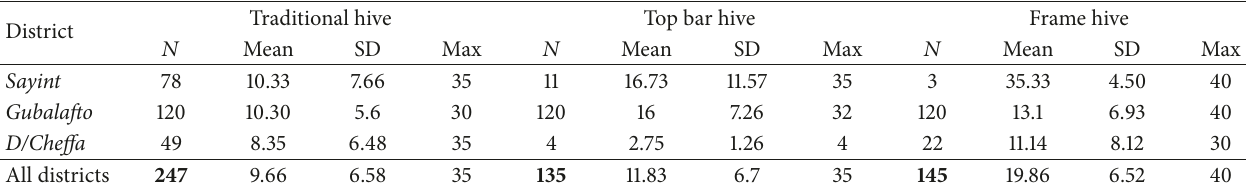
Table 2: Average yield of honey (kg) harvested from different types of hives by districts. District